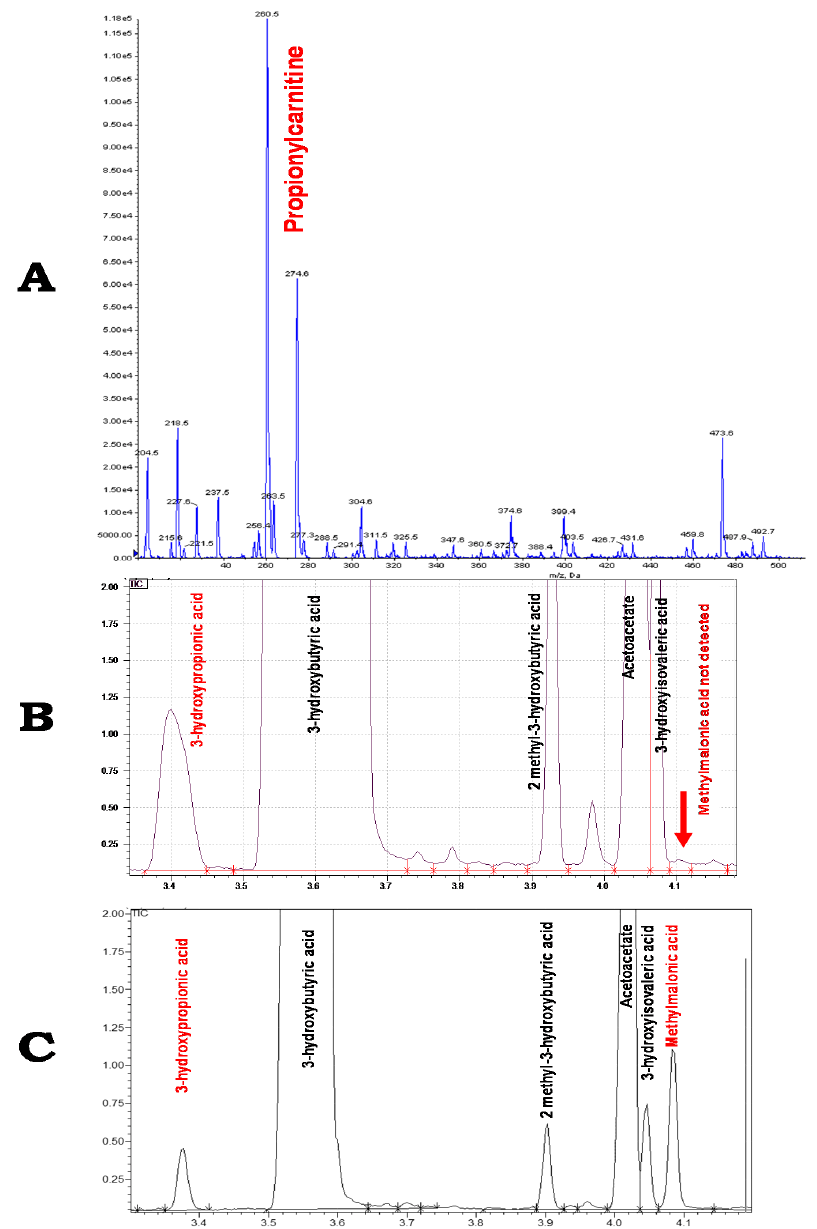
Figure 2. Acylcarnitine and urinary organic acid profiles. ( A ) Acylcarnitine profile using LC-MS/MS showing an elevation in propionylcarnitine following the acute metabolic crisis; ( B ) Acid organic profile using GC-MS presenting a high concentration of 3-hydroxypropionic acid with no methylmalonic acid detection; ( C ) Organic acid profile presenting a moderate increase of 3-hydroxypropionic acid and methylmalonic acid concentrations during follow-up, distant from any decompensation. 1.00e 4 = 10,000; 1.00e 5 = 100,000.